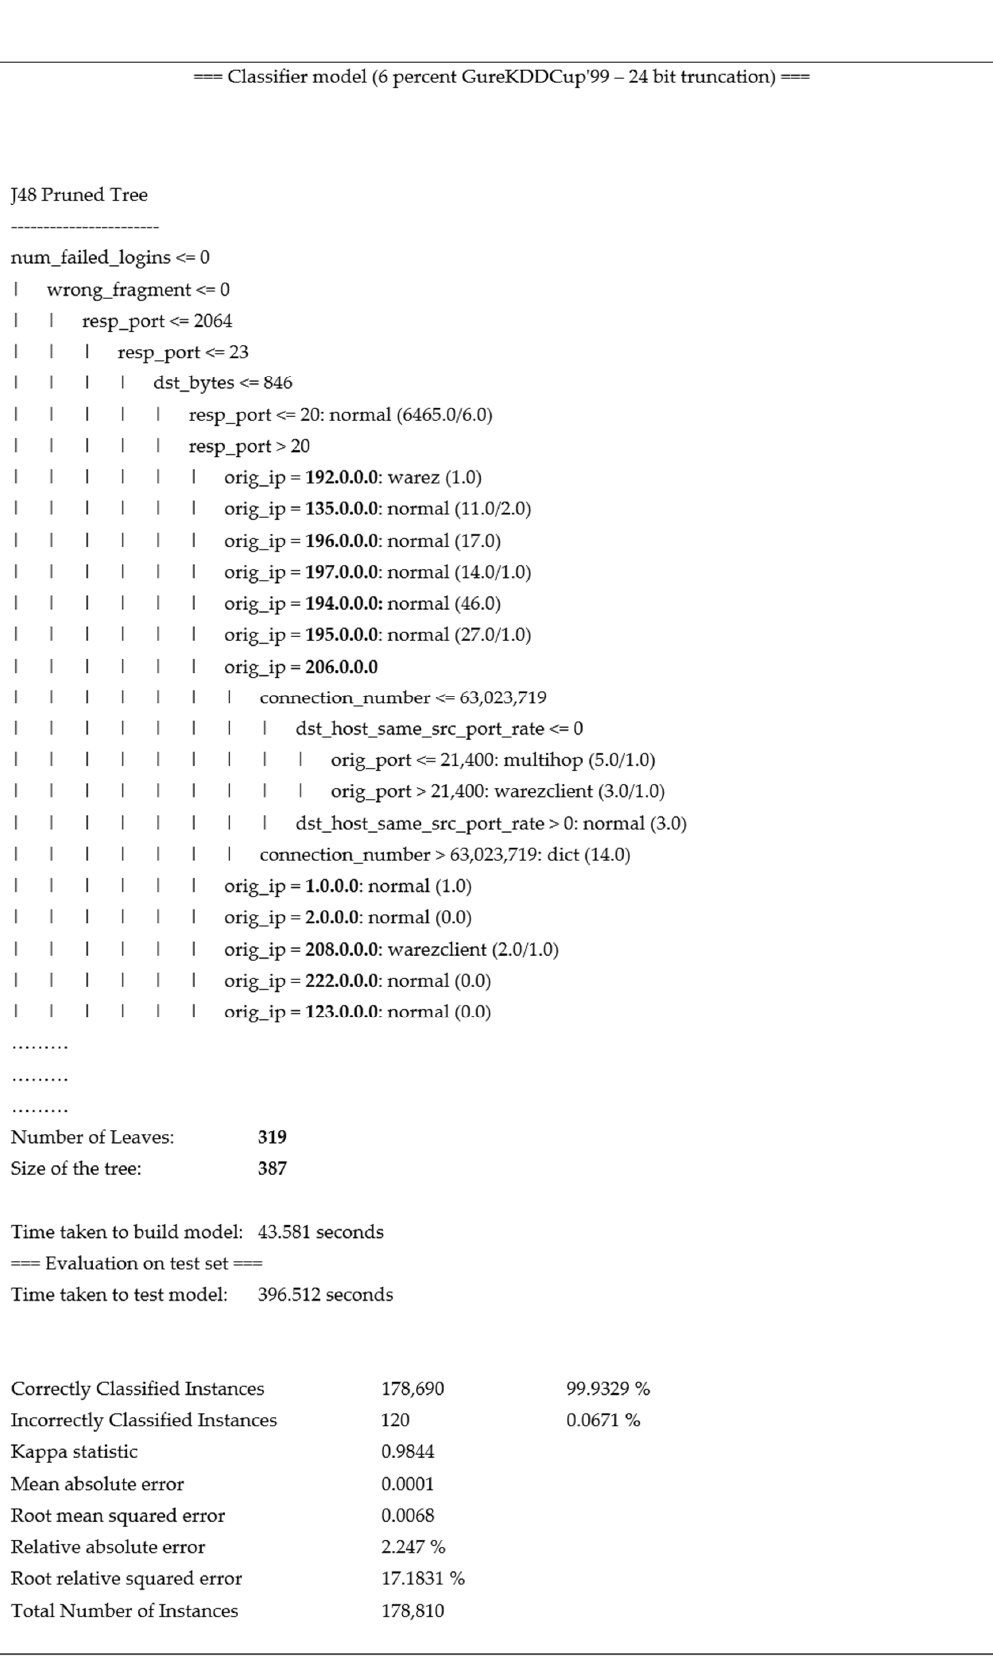
Figure 2. ASCII J48 (Weka implementation of C4.5) Pruned Tree Model (partial), Performance Result on 6 Percent ‐ GureKDDCup’99 (24 ‐ bit Truncation).